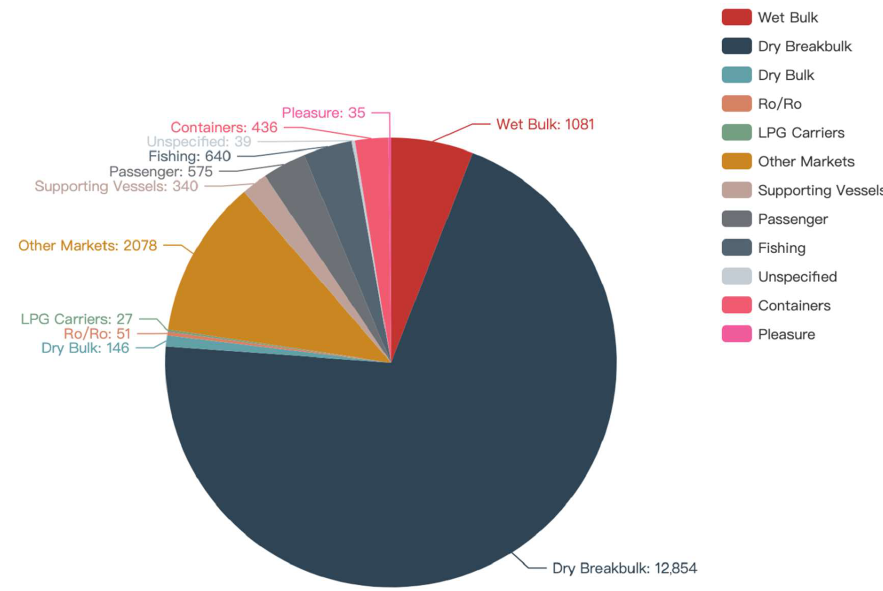
Figure 5. A pie chart of the ship types in Shanghai Port.